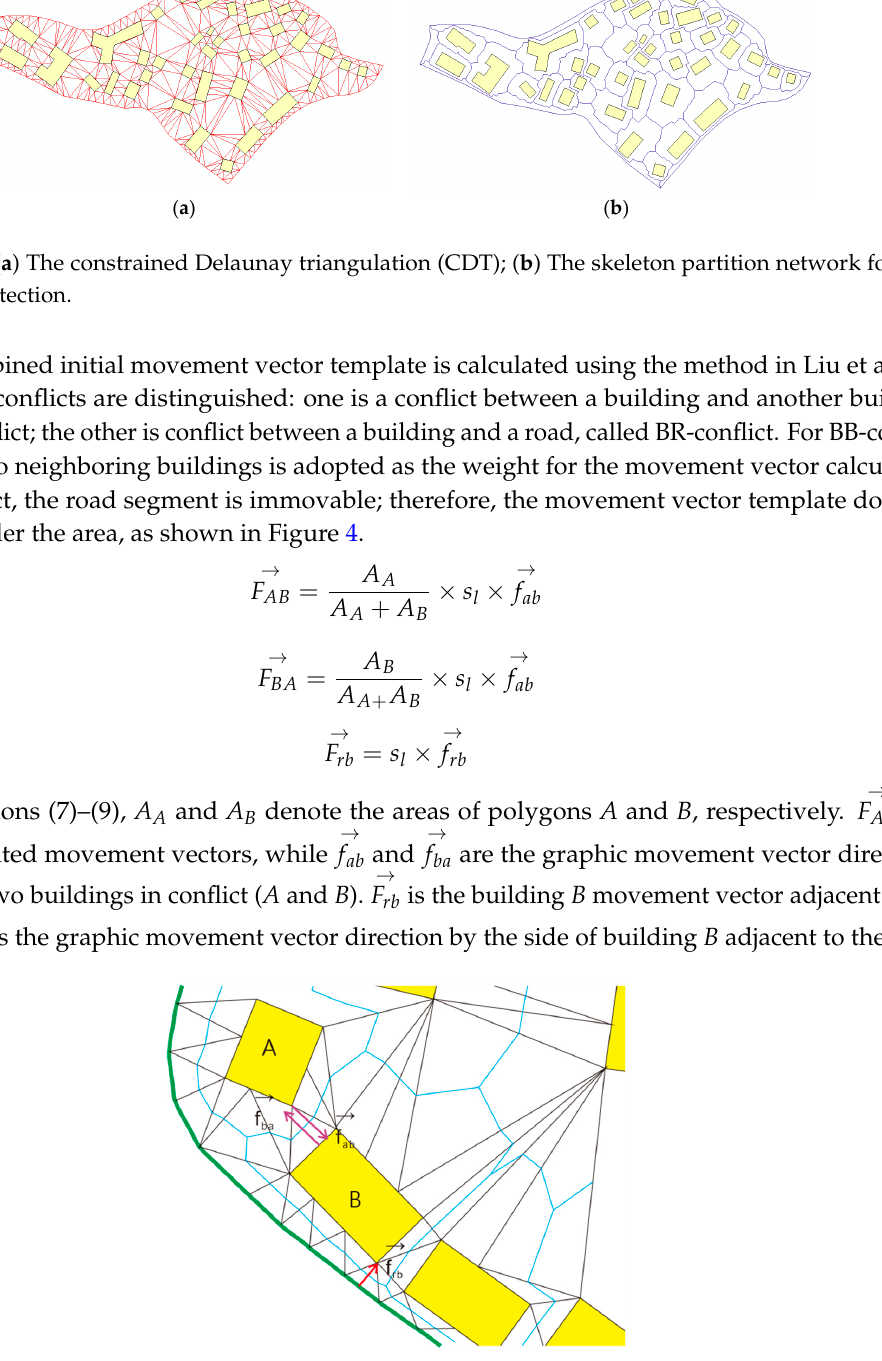
Figure 4. BB-conflict and BR-conflict.